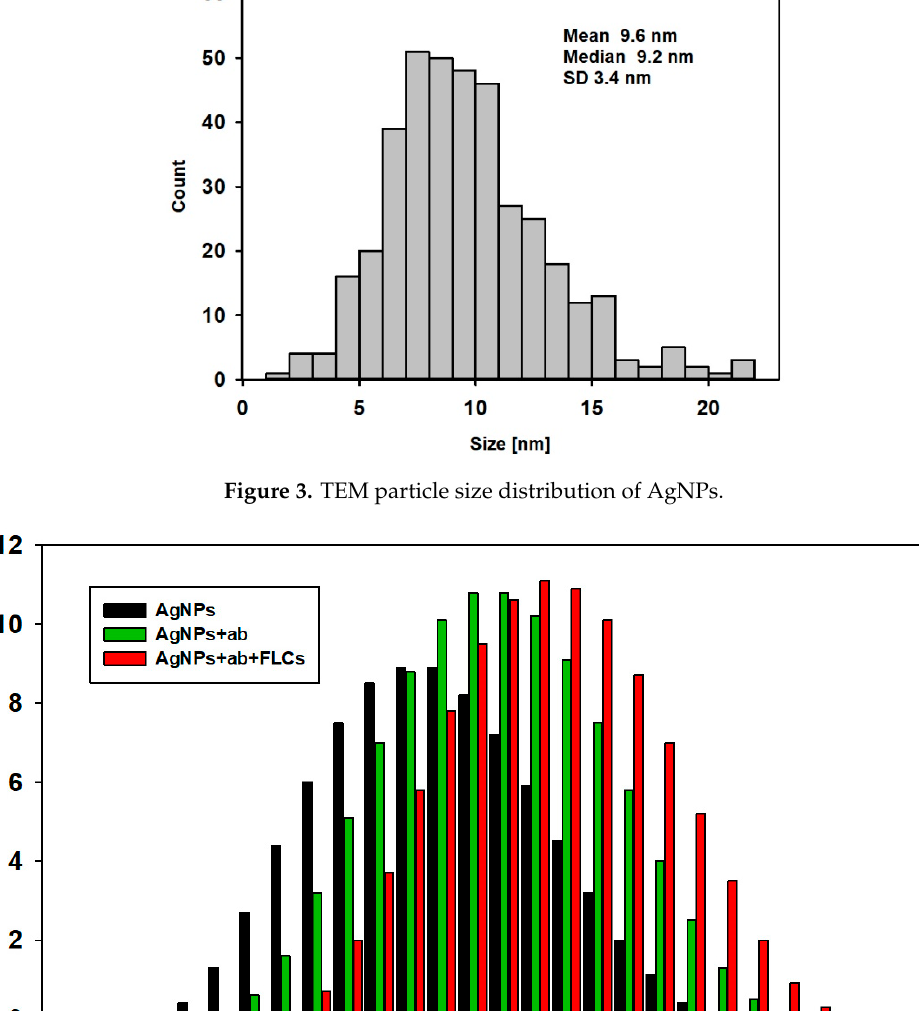
Figure 3. TEM particle size distribution of AgNPs.